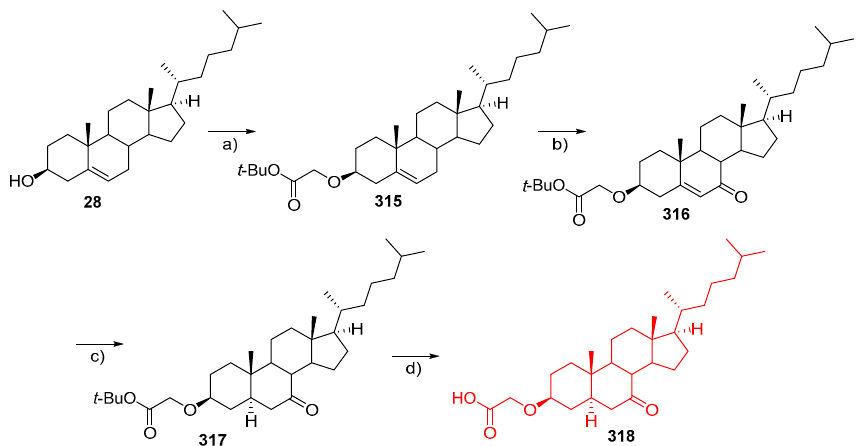
Scheme 77. Synthesis of carboxylic acid cholesterol derivative. Reagents and conditions: a ) t -BuOK, ◦ C, 17 h; b ) 70% aq t -BuOOH, PDC, celite, benzene, 25 ◦ C, 24 h; c ) H t -butyl bromoacetate, toluene, 25 °C, 17 h; b ) 70% aq t -BuOOH, PDC, celite, benzene, 25 °C, 24 h; c ) t -butyl bromoacetate, toluene, 25